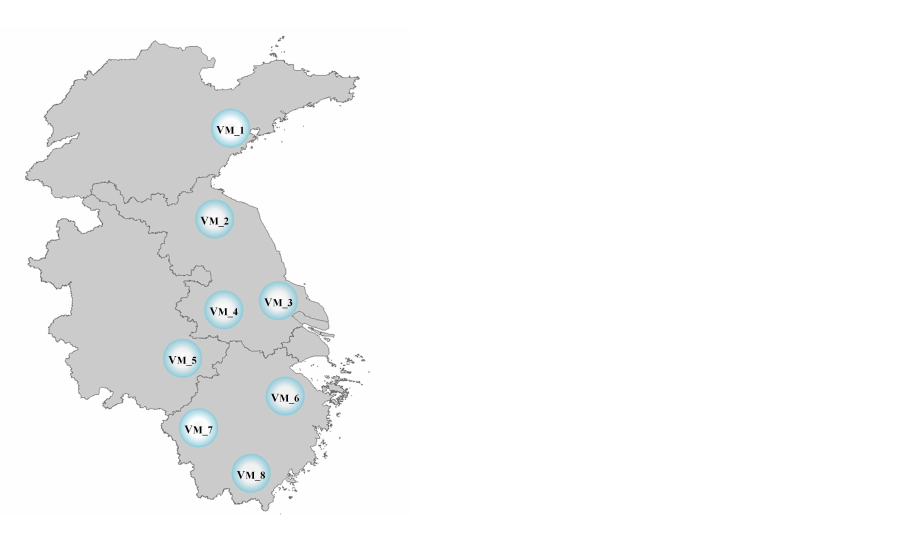
Figure 1. Decomposition of events in the spatial dimension in storm surge